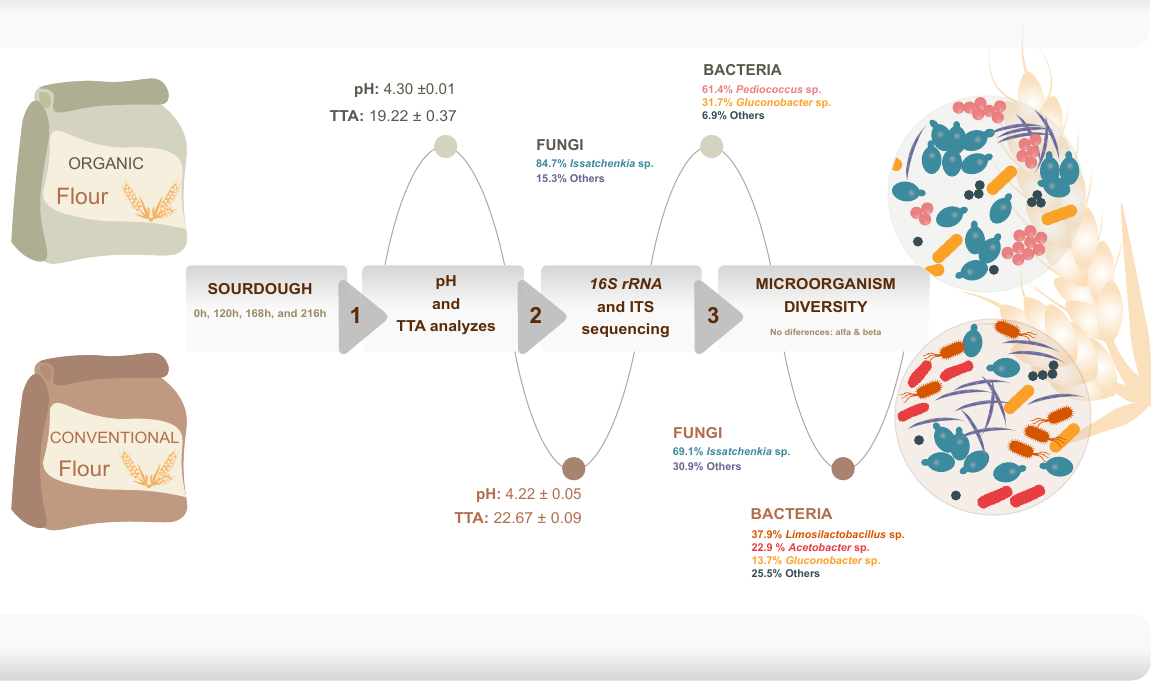
Figure 4. Scheme showing the main results obtained in spontaneous sourdoughs prepared with organic or conventional whole wheat flours from South